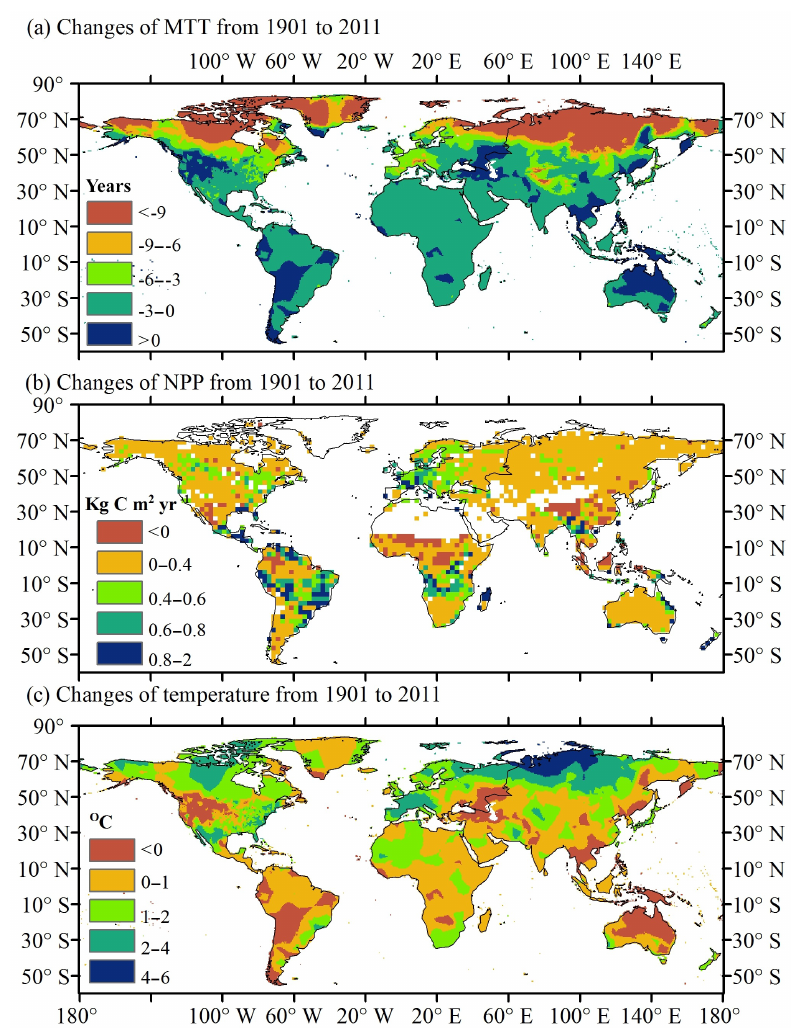
Figure 6. Changes in mean ecosystem mean turnover time (MTT, unit: year) driven by temperature change (a) , changes in NPP (unit: kgCm − 2 yr − 1 , b ) and changes in temperature ( ◦ C, c ) from 1901 to 2011. Changes in MTT from 1901 and 2011 were calculated by the temperature-dependence function showing in Fig. 4. Changes in NPP from 1901 and 2011 were derived from the models’ average and